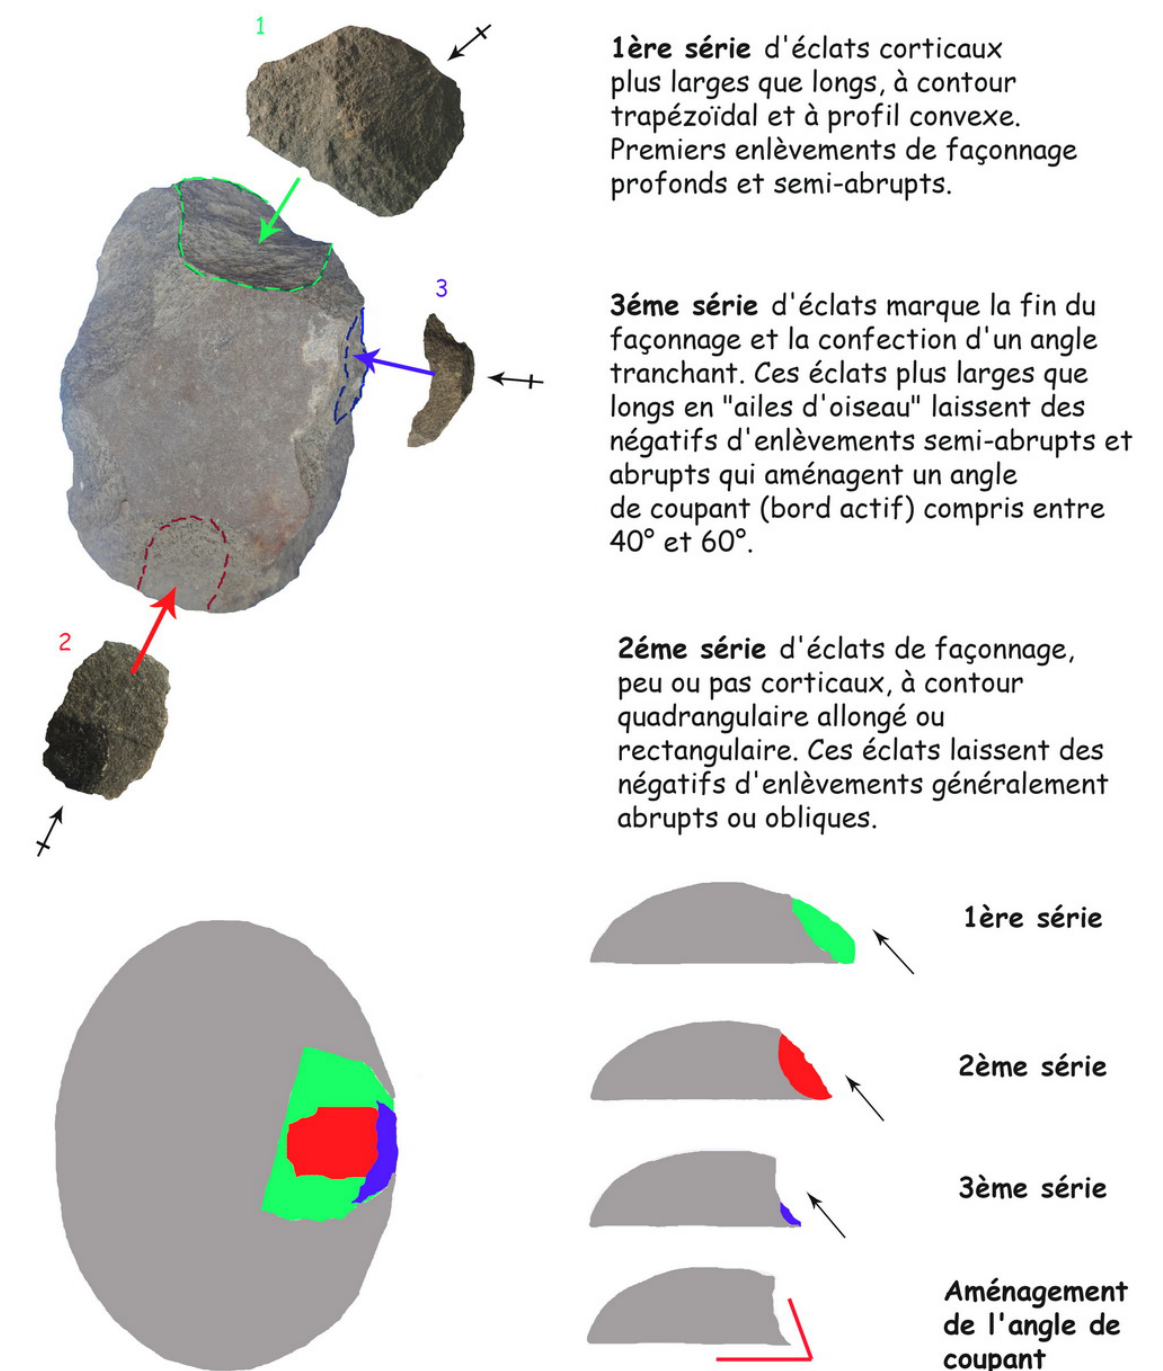
Figure 11. Chaîne opératoire de façonnage d’un uniface hoabinhien. Figure 11. Chaîne opératoire of Hoabinhian uniface